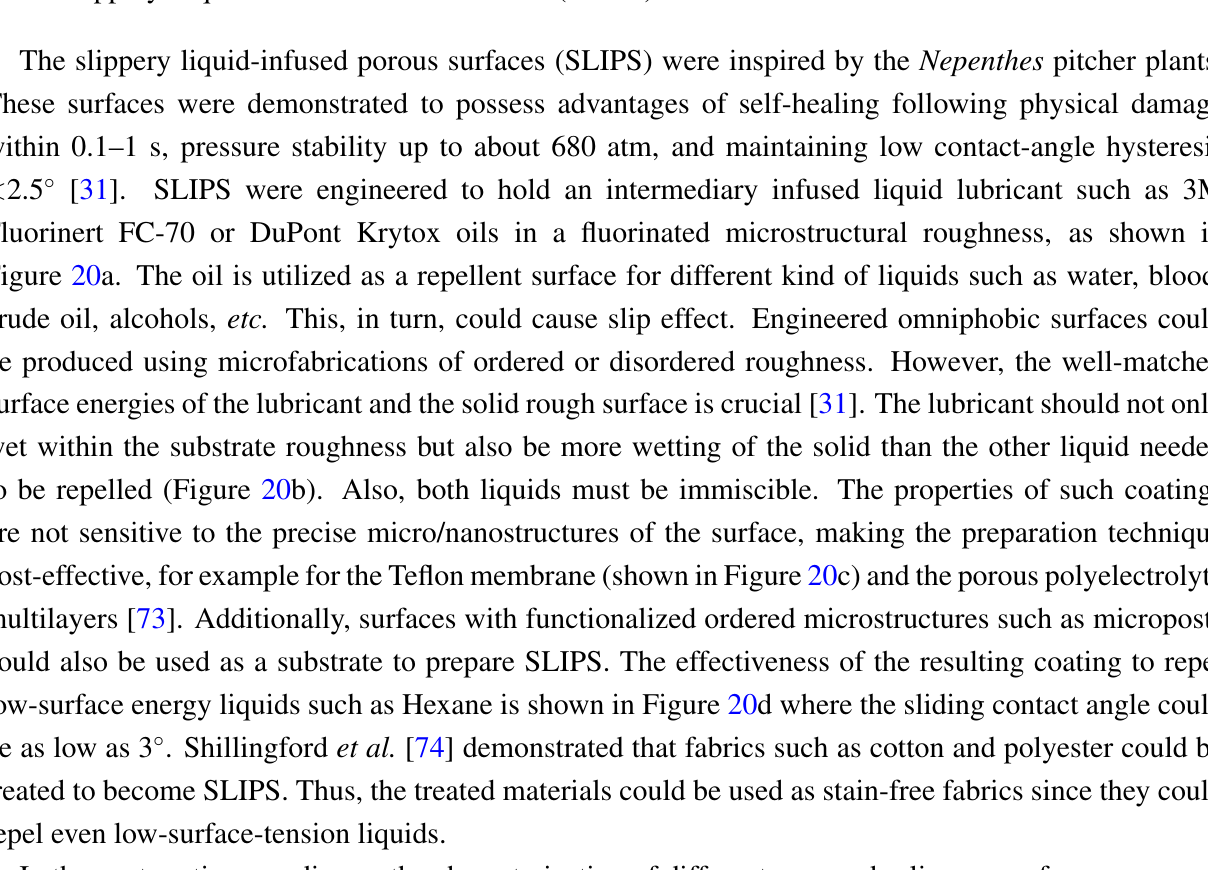
= 593 k, PDI = 2.69) of differing w and receding θ ∗ contact angles. From rec adv